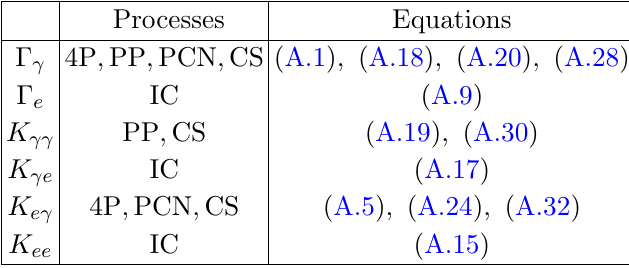
Table 2 . Summary of the contributions to relaxation rates and energy transfer